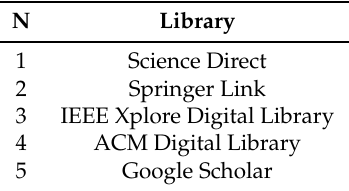
Table 2. Digital